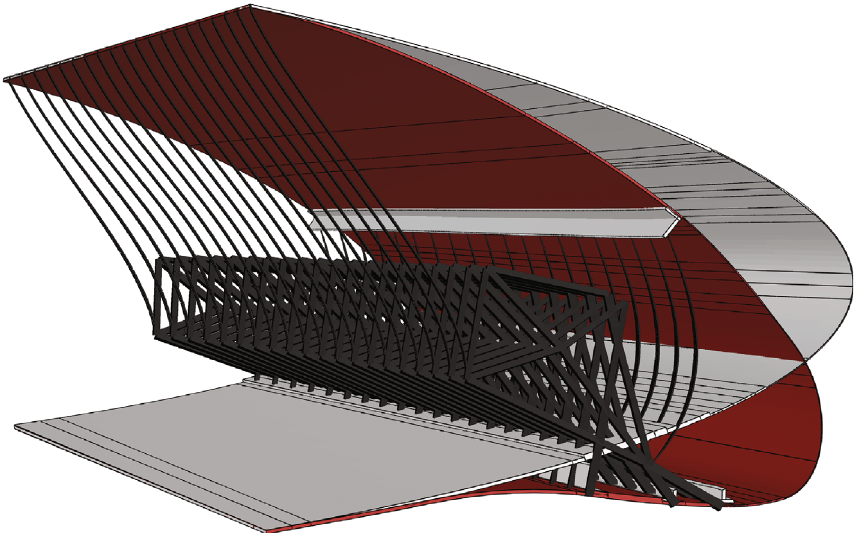
Figure 7: Three-dimensional deformed shape of the deployed droop